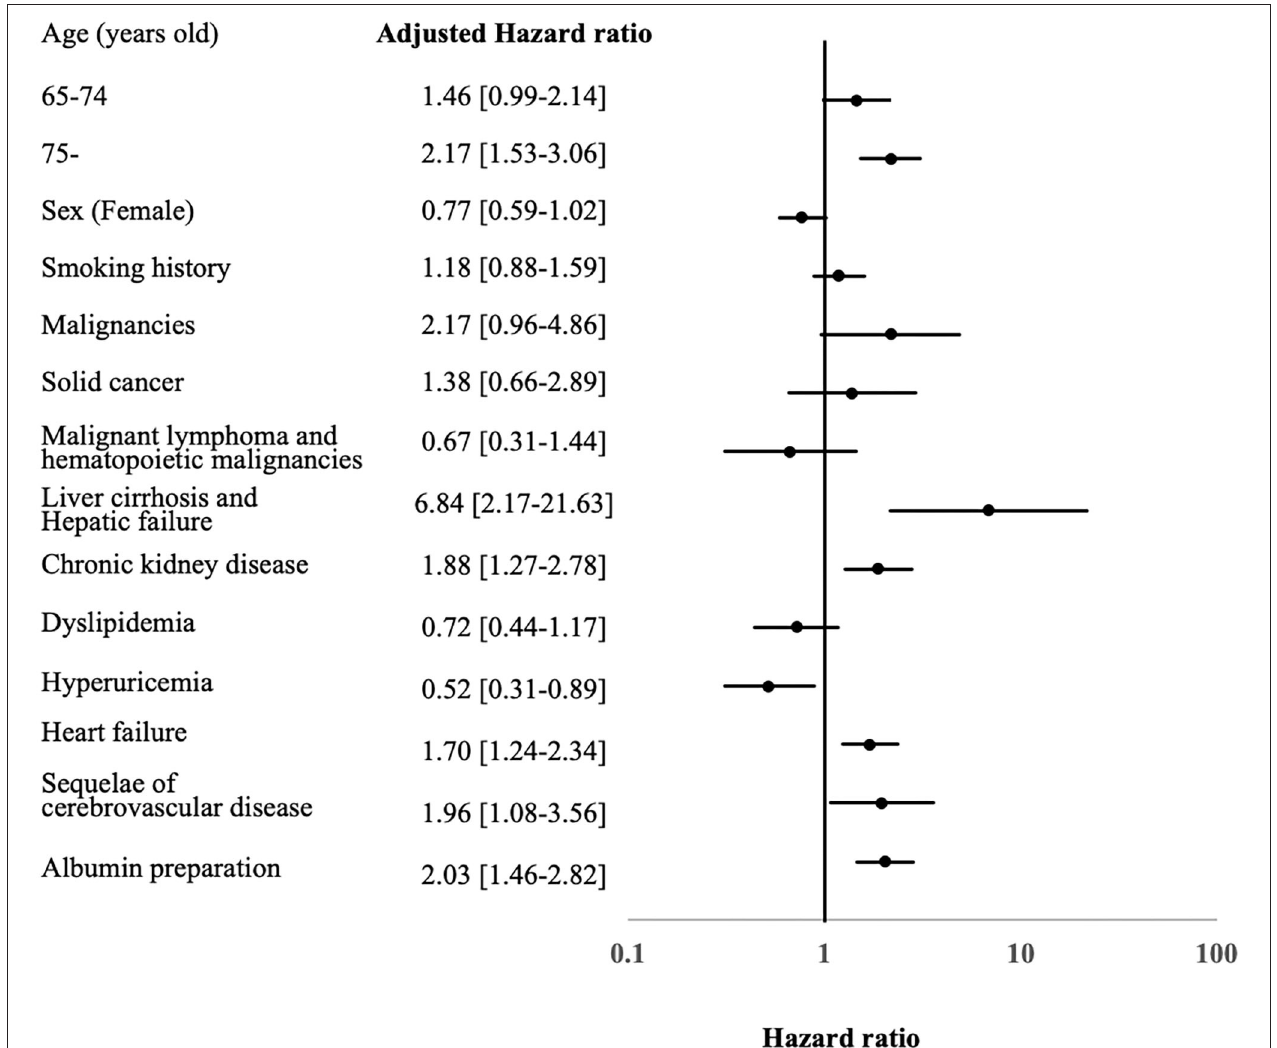
FIGURE 3 | Predictors for poor prognosis of hospitalized herpes zoster cases. aHR, adjusted hazard ratio; C-CVE, cerebro-cardiovascular events; 95% CI, 95 percent confidence interval.